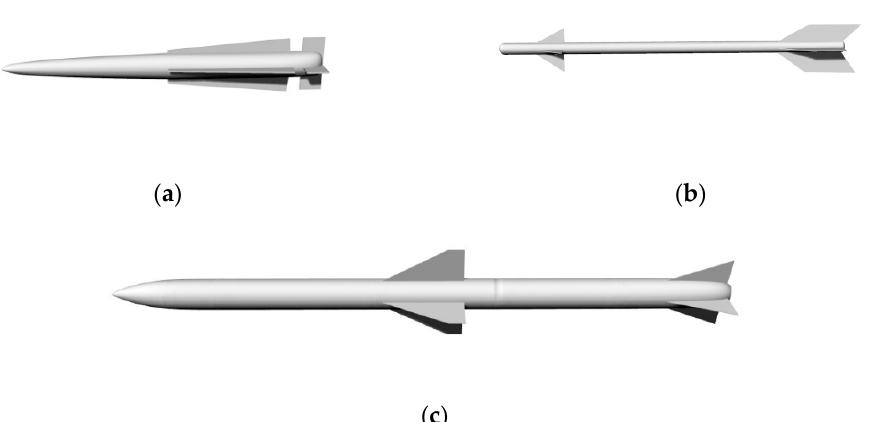
Figure 15. The geometry structure of di ff erent types of missile-like targets: ( a ) type 1; ( b ) type 2; ( c ) type 3.